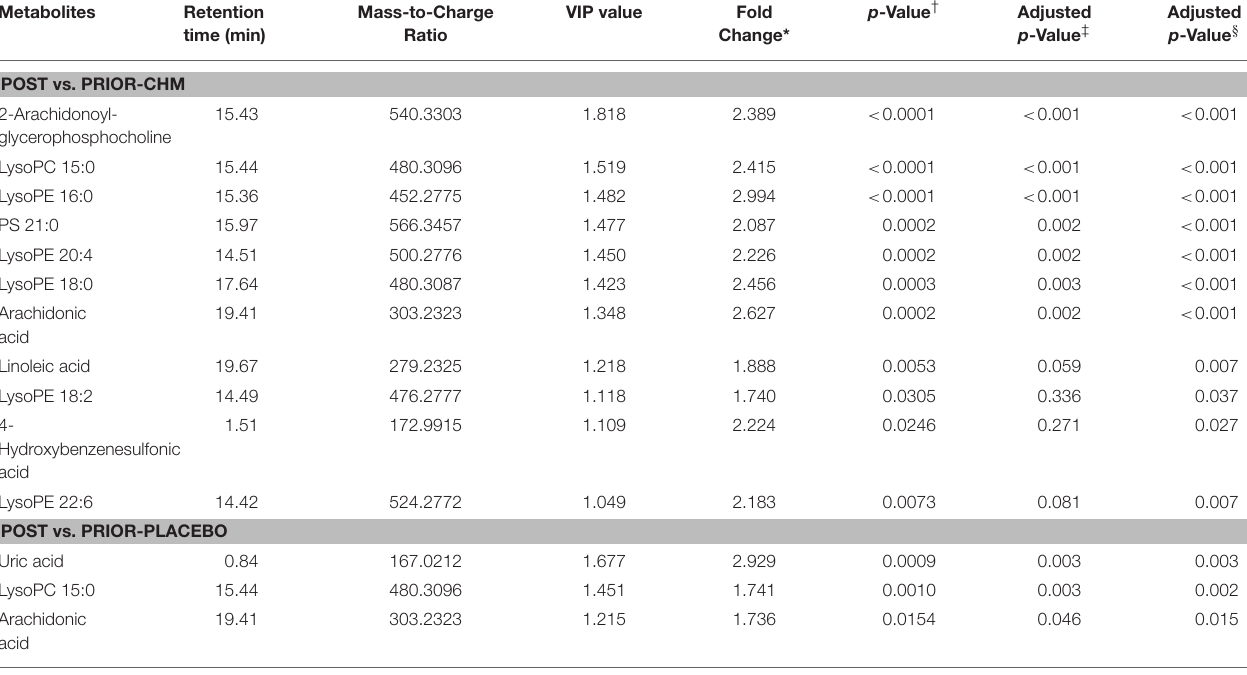
TABLE 3 | Statistical analysis of treatment biomarkers: post vs. prior-CHM and post vs. prior-Placebo. Metabolites Retention Mass-to-Charge time (min)